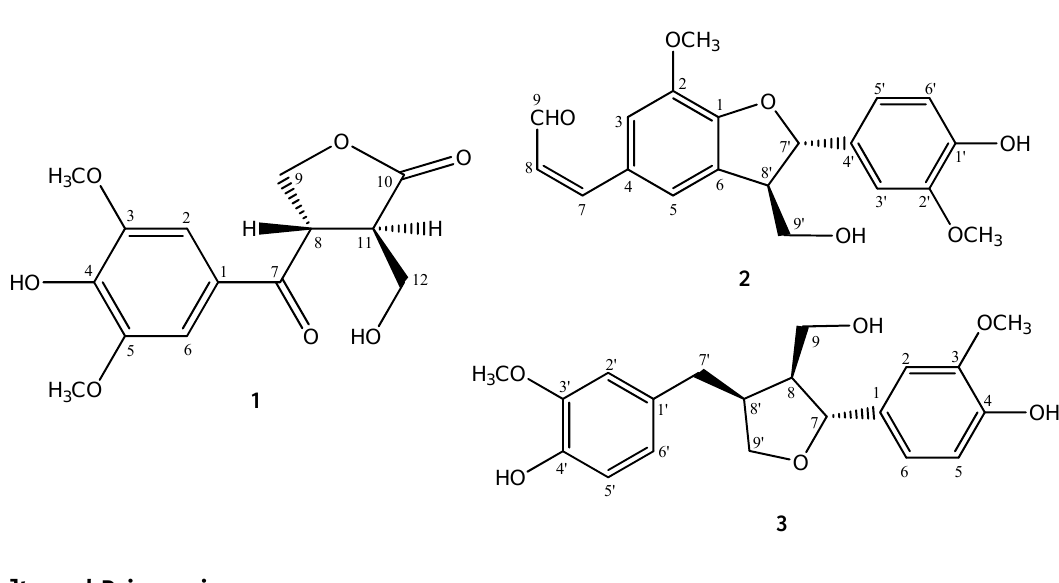
Figure 1. Structures of compounds 1 − 3